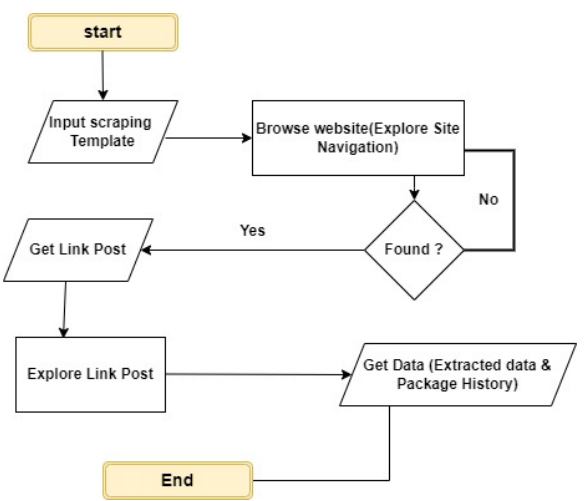
Fig. 2. Block diagram of proposed scraper